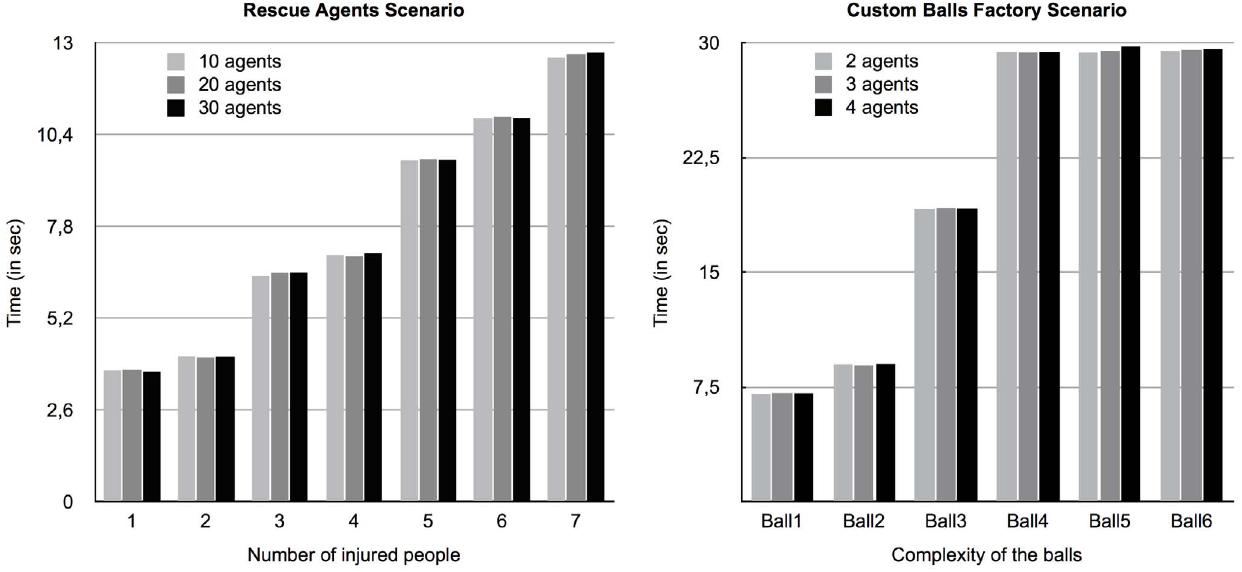
Figure 3. Evolution of the performance of the algorithm in both testing scenarios. Evolution of performance of the Operators-graph-based Distributed Graphplan in both testing scenarios (with the Rescue Agents scenario on the left panel and the Custom Balls Factory scenario on the right panel) as skills distribution increase. The given number of agents is per skill.